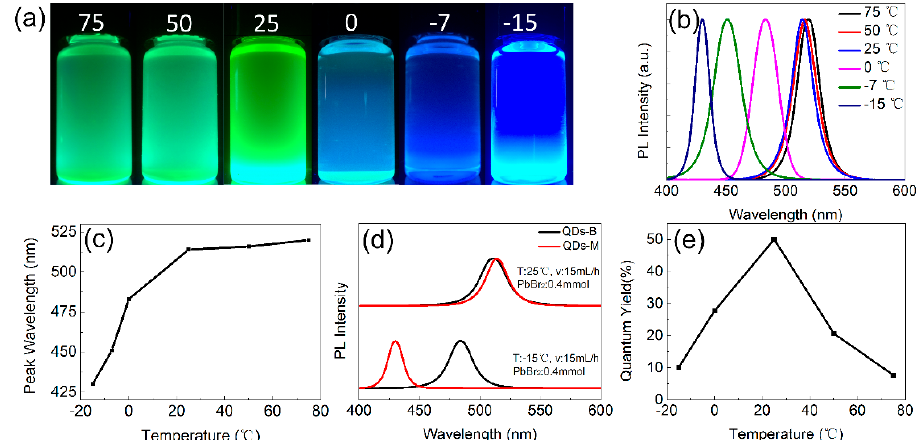
Figure 4. ( a ) Digital images under the UV light of 365 nm; ( b ) emission spectra; and ( c ) wavelength statistical chart of QDs-M at different reactor temperatures, where toluene is used as the weak polar solvent; ( d ) Comparison graph of the emission spectra of QDs-M and QDs-B with toluene as the weak polar solvent. (T represents temperature, v represents precursor flow velocity and PbBr 2 represents dosage of PbBr 2 ); (e) The QYs of QDs-M with different temperatures.